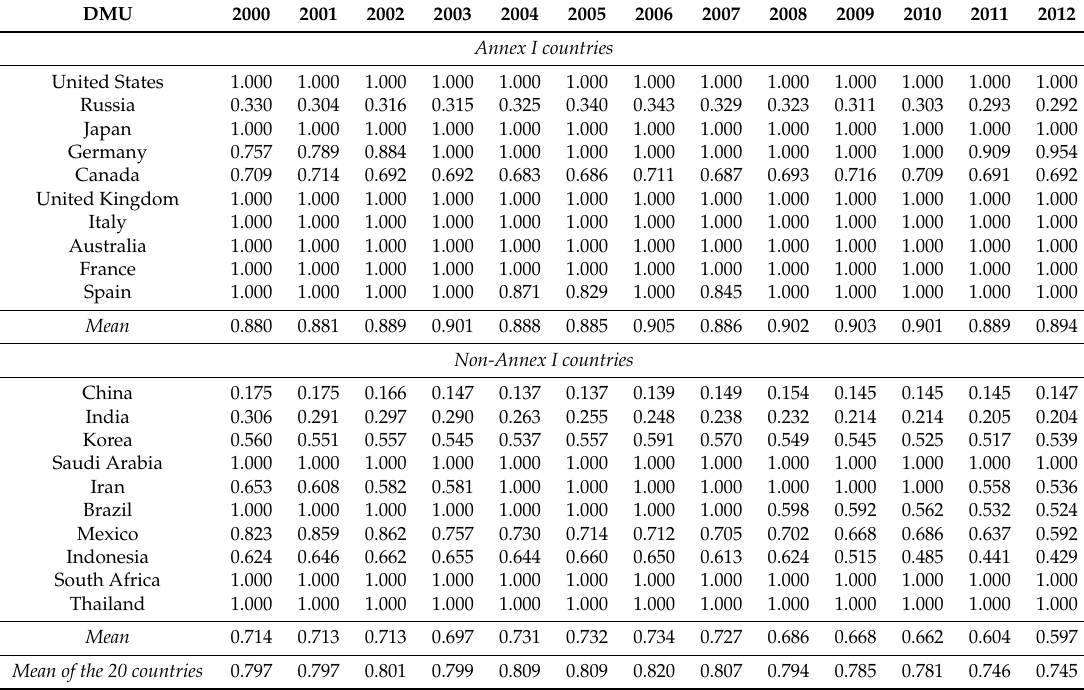
Table 3. The scores of Efficiency of the stage 1 in years